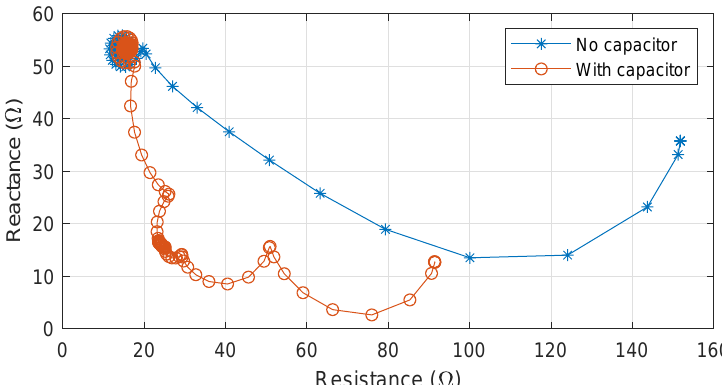
Figure 4. Impedance trajectory in RX plane for the same fault without and with series